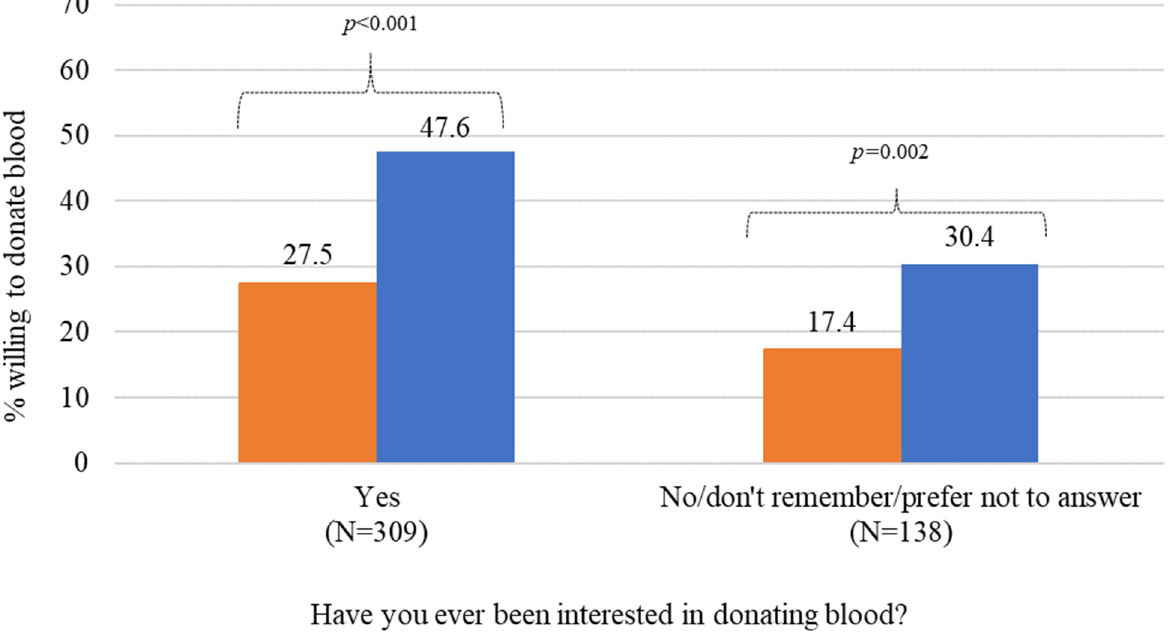
Fig 2. Willingness to donate blood under 12-month and 3-month deferral policies by general interest in donating blood (N = 447). Orange bar: 12-month deferral policy; Blue bar: 3-month deferral policy. Note : Reported p-values are from McNemar chi-square test for paired categorical